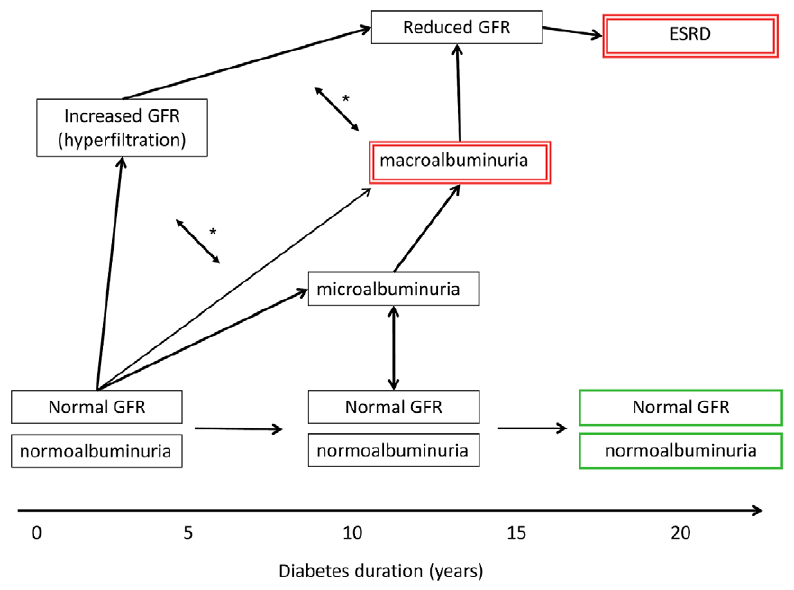
Figure 1. Schematic presentation of variable clinical courses of diabetic nephropathy. The case and control definitions used in the primary GWAS in Sandholm et al. [9] are indicated by green bold (controls) and red double-lined boxes (cases). GFR, glomerular filtration rate; ESRD, end stage renal disease. Microalbuminuria, urinary albumin excretion rate of 30–300 mg per day; macroalbuminuria, urinary albumin excretion rate of . 300 mg per day. *, GFR and albuminuria may progress independently of each other, i.e., patients may have micro- or macroalbuminuria even though their GFR is normal or even slightly elevated. However, macroalbuminuria is usually associated with reduced GFR, and is a strong risk factor for progressive loss of eGFR and